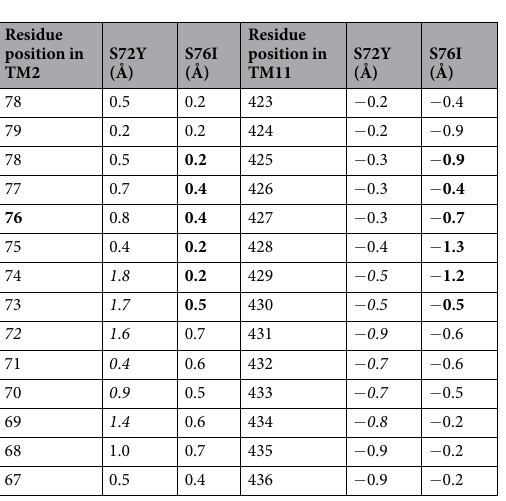
Table 1. Movement of C α atoms of TM helices 2 and 11 in GLUT5 S72Y or GLUT5 S76I relative to those in the wild-type, for the inward-facing conformation structures. Average movements for 12 residues around the mutated residues (highlighted in italics for S72Y and bold for S76I) are 2.0 Å (for S72Y) or 1.1 Å (for